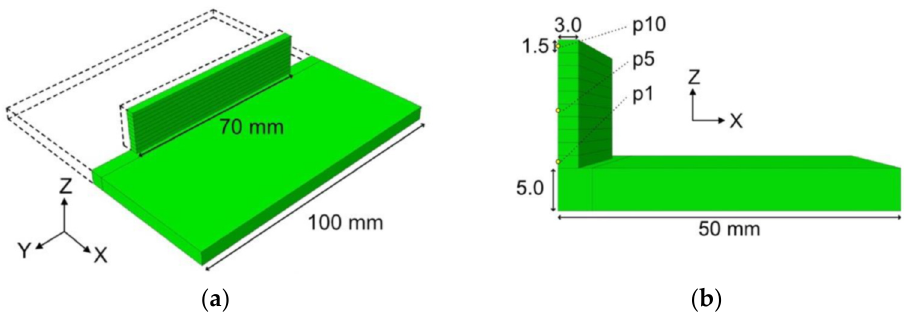
Figure 1. Dimensions of the experimental product. ( a ) Length of substrate and deposition for the y- direction. ( b ) Width and height of substrate and deposition on the x-z cross-section. Table 1. Physical constant of the Ni-based alloy and WAAM process conditions. Density, 𝜌 8250 kg/m 3 Heat capacity, 𝐶 (cid:3043) 451.9 J/g/K Liquidus temperature, 𝑇 (cid:3039) 1345 °C Solidus temperature, 𝑇 (cid:3046)